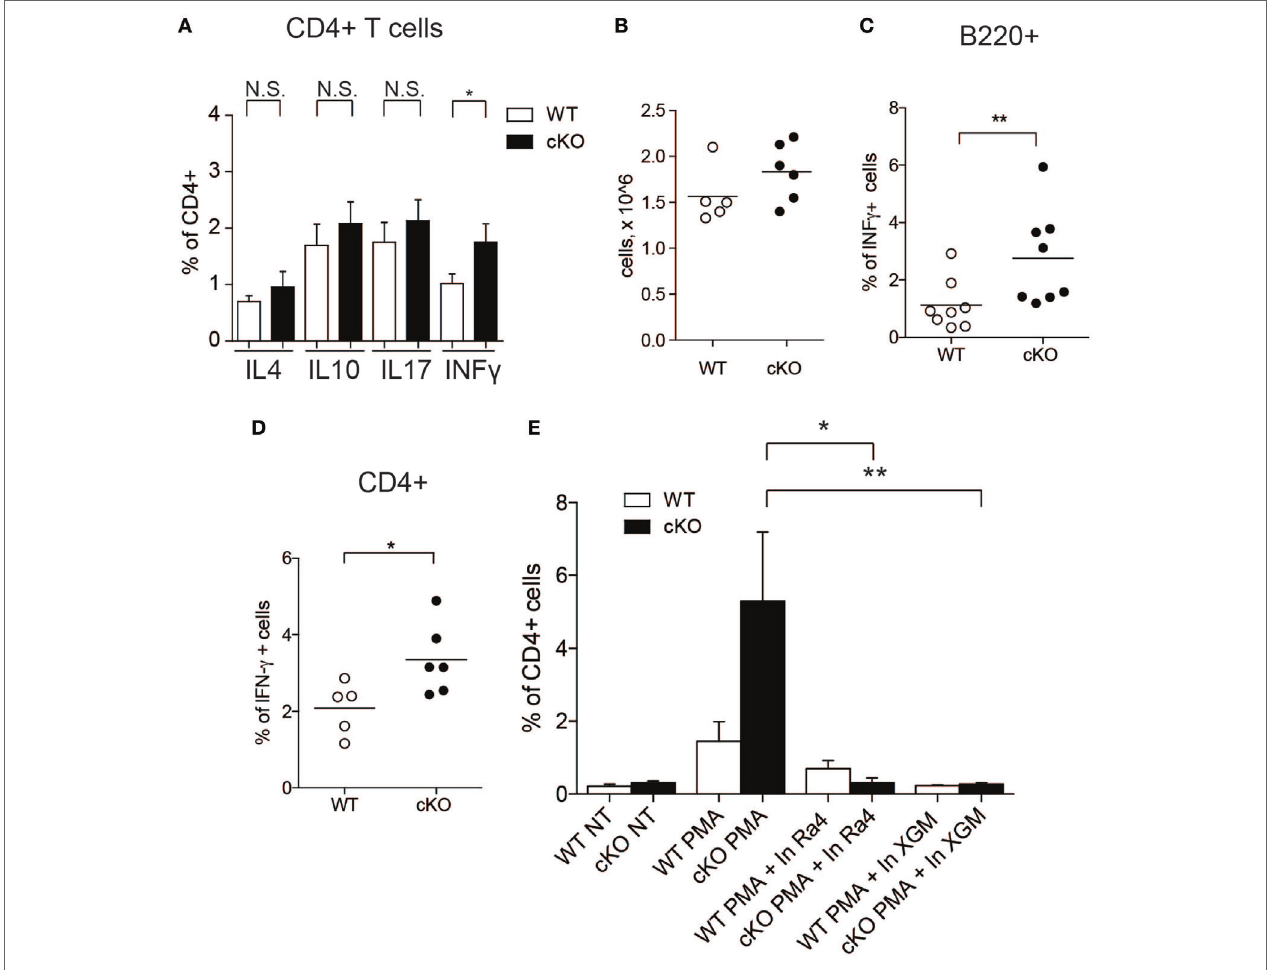
FigUre 3 | Lack of glucocorticoid-induced leucine zipper (GILZ) in B cells leads to increased production of IFN- γ by splenic T cells and in peripheral blood. (a) Analysis of IFN- γ cytokine production by CD4 + cells in the spleen of wild-type (WT) and gilz B cKO mice. (B) Cell counts of WT, gilz B cKO B, and T cells co-cultured and stimulated in vitro with phorbol 12-myristate 13-acetate (PMA)/ionomycin and lipopolysaccharide (LPS) for 24 h. (c,D) Flow cytometry analysis of IFN- γ production in B cells [ (c) , B220 + ] or T cells [ (D) , CD4 + ] co-cultured and stimulated in vitro with PMA/ionomycin and LPS for 24 h. (e) Flow cytometry analysis of IFN- γ production in B and T cells co-cultured and stimulated in vitro with PMA/ionomycin and LPS for 24 h with or without anti-IFN- γ antibodies (Ra4 and XGM; n = 9, 10); N.S., not significant; statistical analysis was performed using the unpaired Student’s t -test (* p < 0.05, ** p <